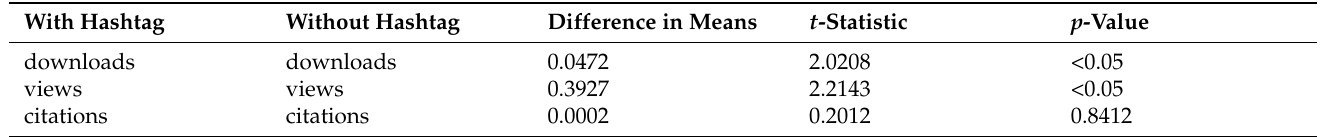
Table 11. Results of the Welch’s test on the metrics associated with papers included in the #showmey- ourdata campaign and papers not included in the campaign.